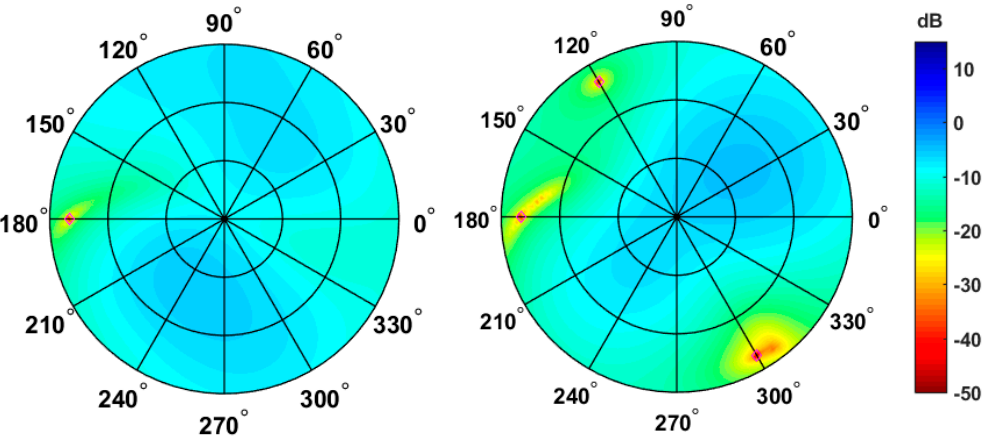
Figure 14. Sky plots of the array gain after applying weights for nulling in the direction of the interferer(s). Interference Direction of Arrival (DOA) marked with a red rhomb. Left : one interferer; right : three interferers.